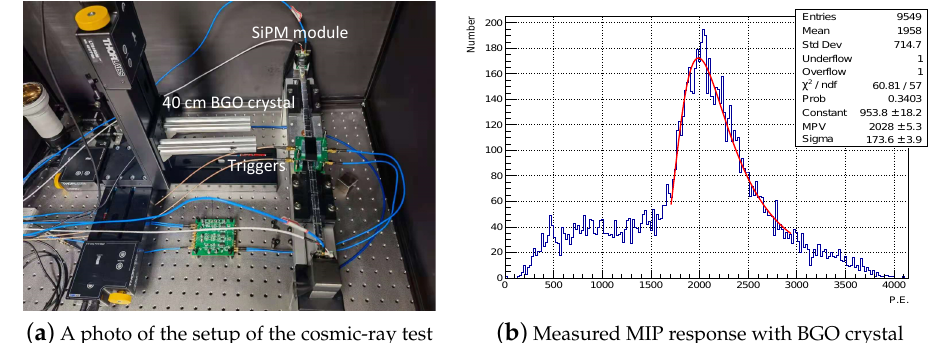
Figure 9. Setup and result of the cosmic-ray test of the BGO